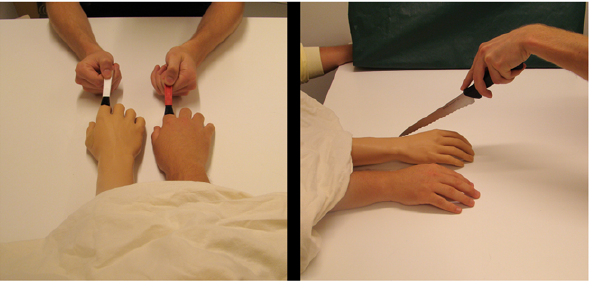
Figure 1. Illusion set-up. Set-up used to elicit the supernumerary hand illusion (left panel) and an illustration of the threat procedure, where we moved a knife close to the rubber hand or the real hand (right